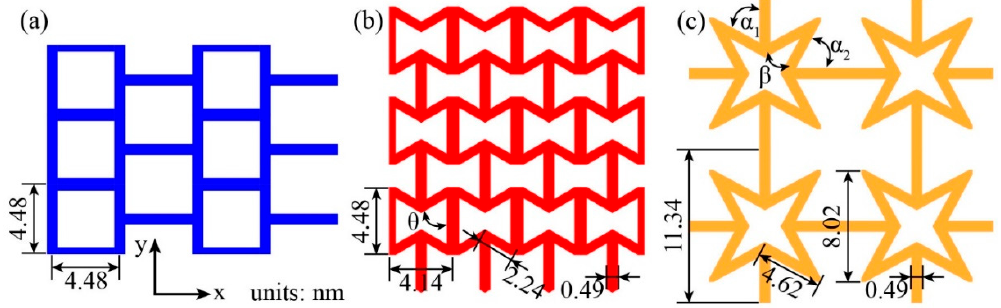
Figure 1. Three models of kirigami graphene structure (KGSs) are used in the present work. ( a ) Square kirigami graphene (SKG) model; ( b ) reentrant hexagonal honeycomb (RHH) model; and ( c ) quadrilateral star structure (QSS).